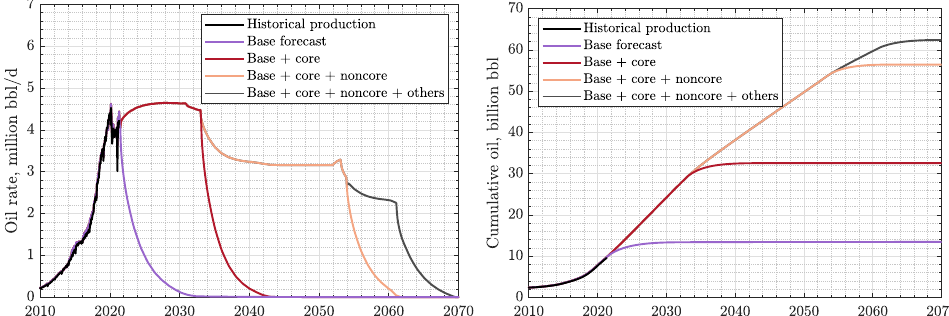
Figure 15. Infill forecast scenario for oil production in the Permian tight reservoirs. The total field